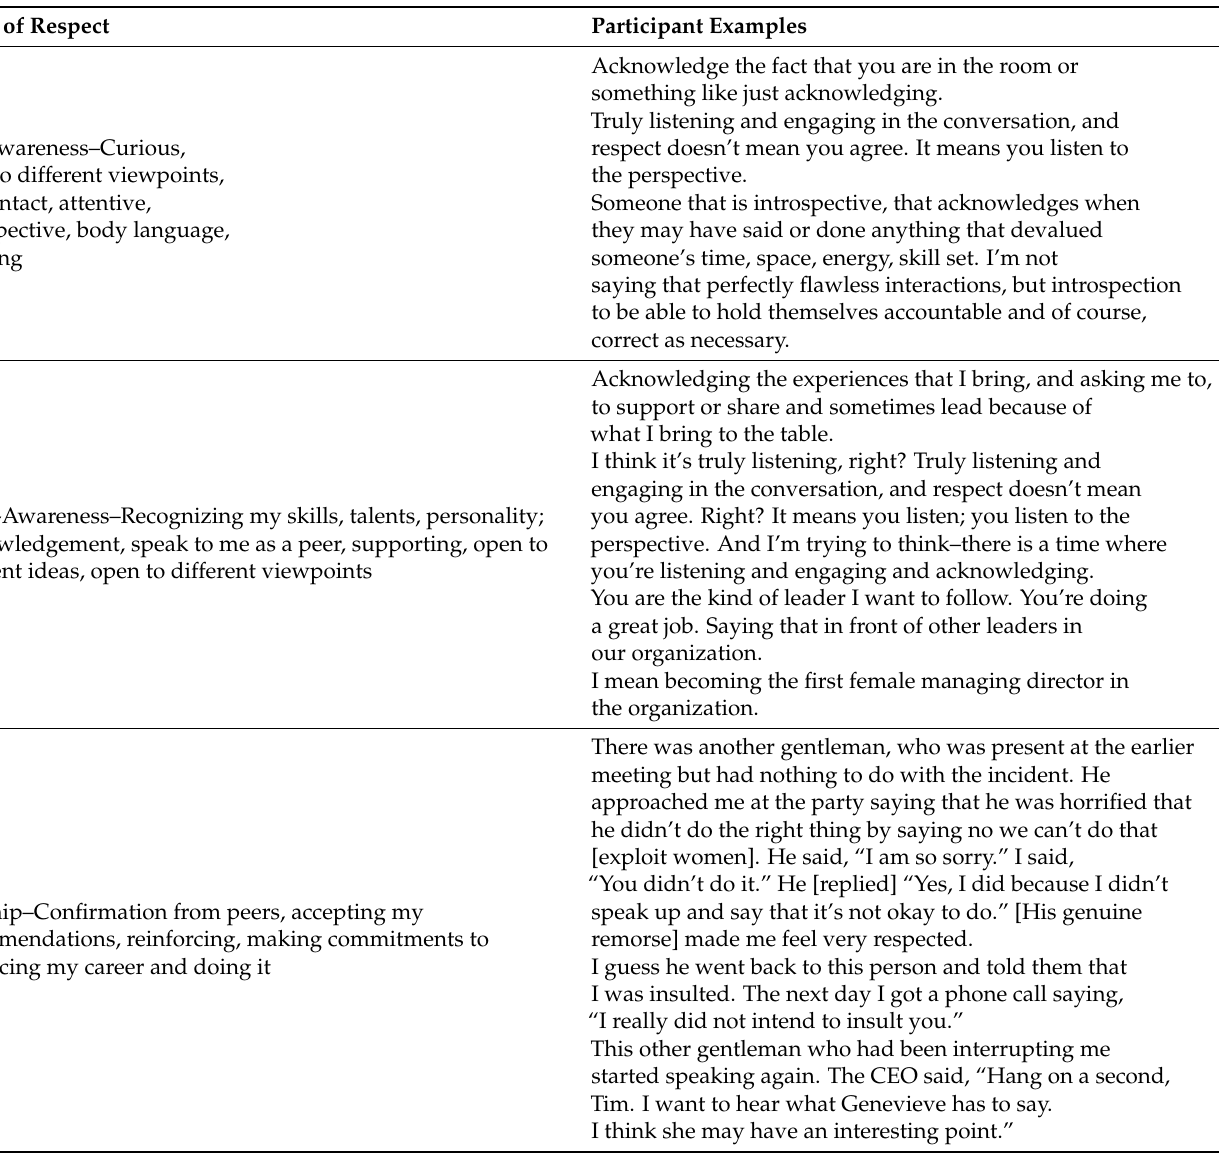
Table 3. Types of Respect and Participant